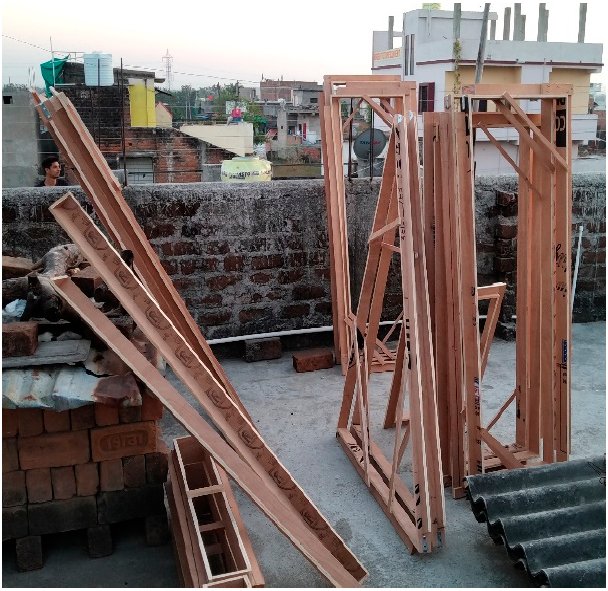
Figure 8. Wooden moulds.